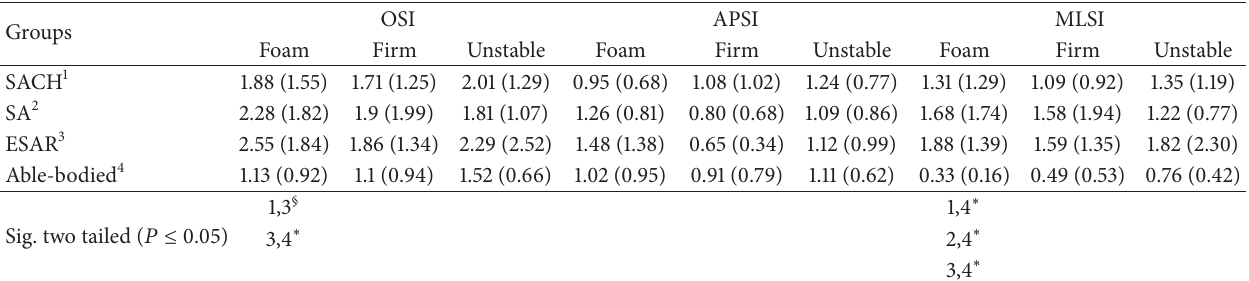
Table 2: The average and standard deviation of each prosthetic foot and control group during standing on different support surface